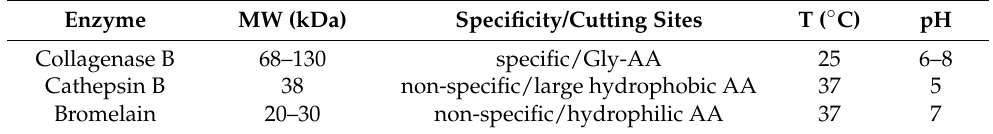
Table 1. Molecular weight, specificity, cutting sites, and optimal pH and Temperature of hydrolysis for the enzymes tested to obtain bovine bone collagen peptides (AA = amino acid) [18]. Enzyme MW (kDa) Specificity/Cutting Sites T ( ◦ C) Collagenase